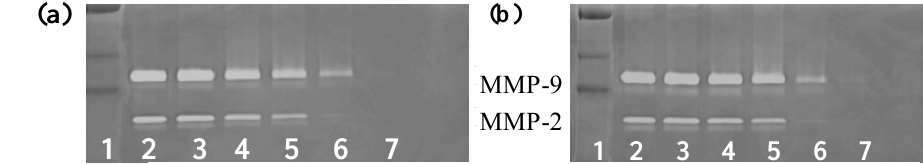
Figure 11. Effect of NM on SK-Hep-1 MMP-2 and -9 secretion: Gelatinase zymograms of ( a ) normal and ( b ) PMA-treated SK-Hep-1 cells; 1: Markers, 2: Control, 3–7: NM 10, 50, 100, 500, 1,000 µg/mL. Densitometry analysis of ( c ) normal and ( d ) PMA-treated SK-Hep-1